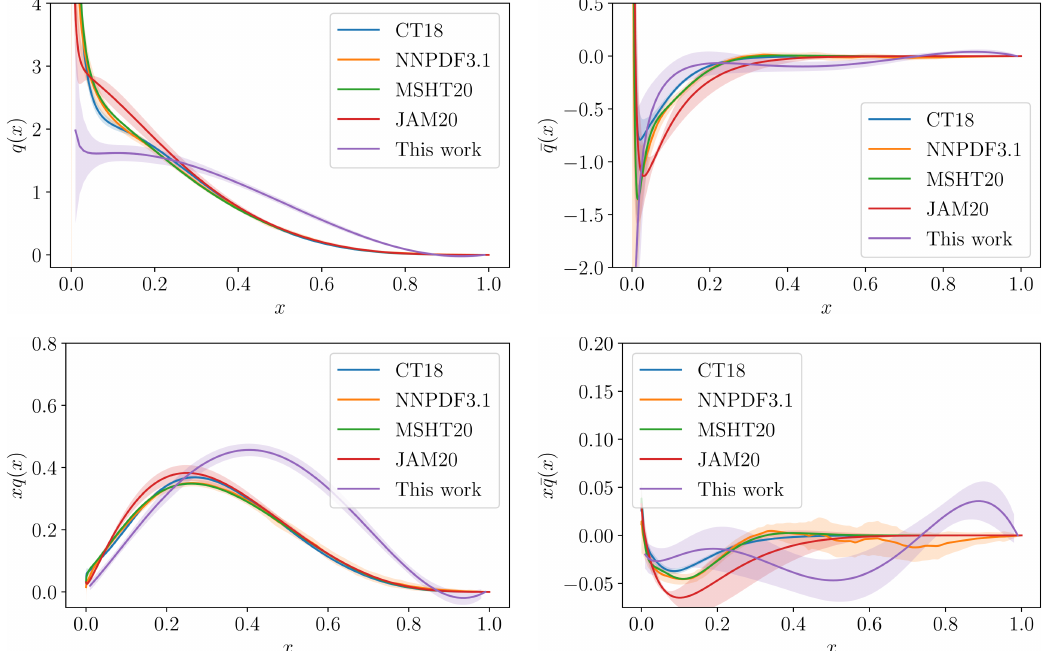
Figure 13 . A comparison of the AICc averaged results to the global fit PDFs, CT18 [124], NNPDF 3.1 [127], MSHT’20 [125], and JAM20 [126]. The upper plots are the parton distributions and the lower plots are the distributions weighted by x to emphasize the large x